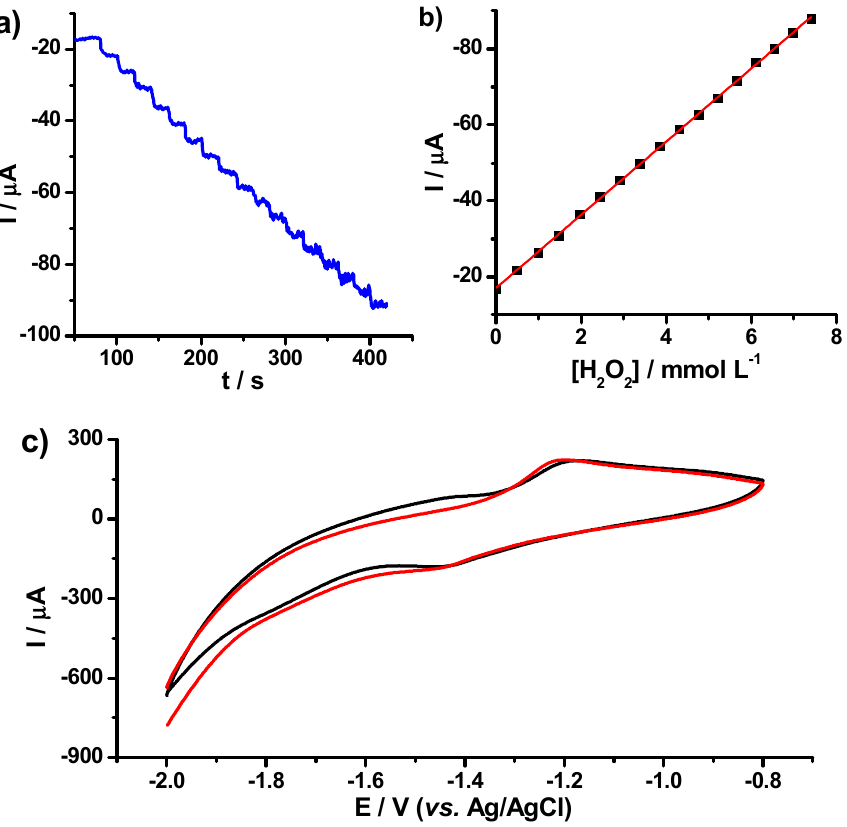
Figure 10. ( a ) Chronoamperometric detection of H 2 O 2 at HRP–TiO 2 / fCNT / GC modified electrode, at − 1.5 V, in 0.1 mol ∙ L − 1 phosphate-buffered solution at pH 7. ( b ) Calibration curve of H 2 O 2 and ( c ) cyclic voltammetry before and after detection.